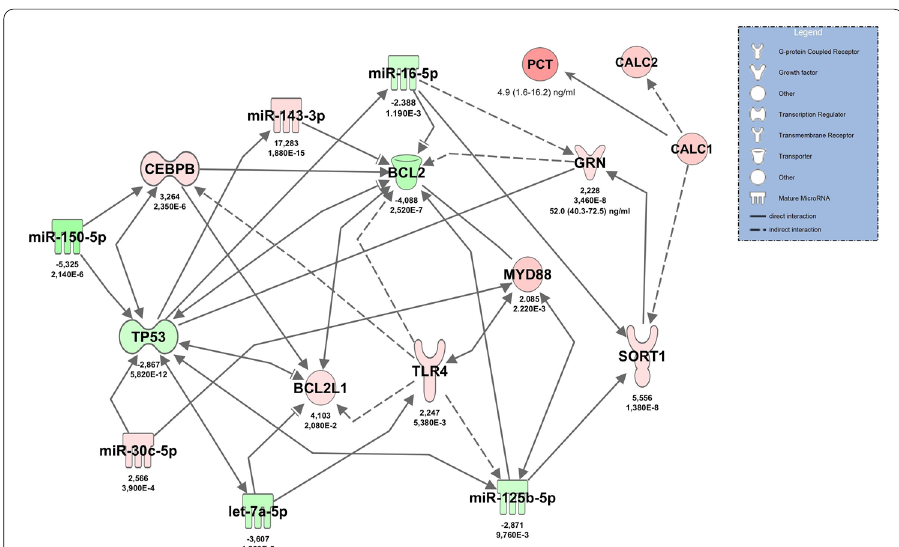
Fig. 9 Illustration of the role of progranulin (GRN gene) in the molecular network activated during the early antimicrobial response in patients with septic shock at admittance to the ICU. The network was constructed using data from high‑throughput sequencing followed by RT‑qPCR confirmation. Red color indicates upregulation in comparison to healthy volunteers, green indicates downregulation. Color shading corresponds to log2FC values, which are reported below the molecules along with FDR‑adjusted p ‑values. The effect of sepsis‑associated upregulation of calcitonin precursors (CALC1) and its gene product procalcitonin on sortilin (SORT1), the principal binding partner of progranulin, is illustrated on the right side of the